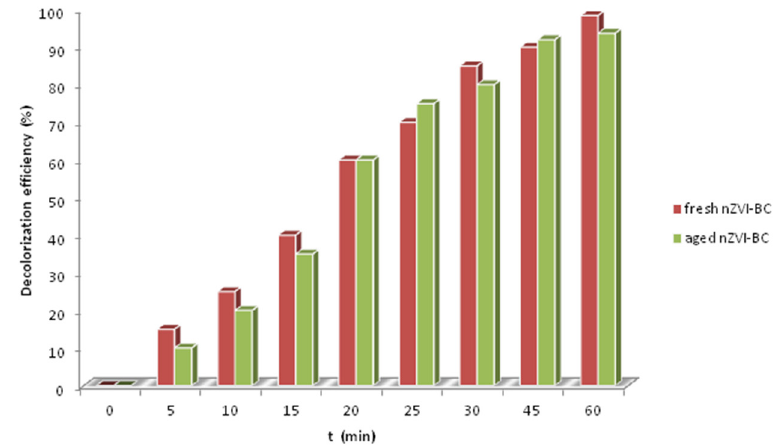
Figure 9. Effects of aging nZVI-BC on RB4 decolorization.